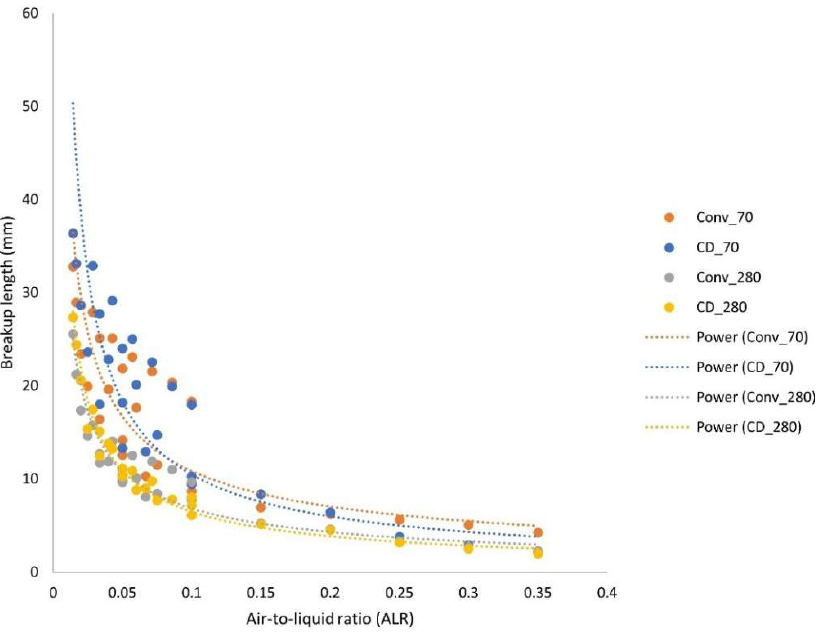
Figure 15. Breakup length measurement variation with ALR for converging and CD atomizer cases with 70 and 280 µm sheet thickness.